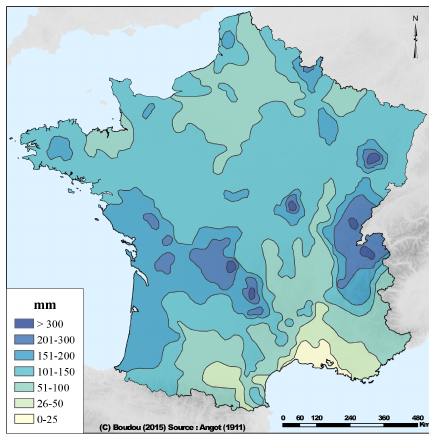
Figure 16. Map of December 1909 precipitation, adapted from An- got (1911).